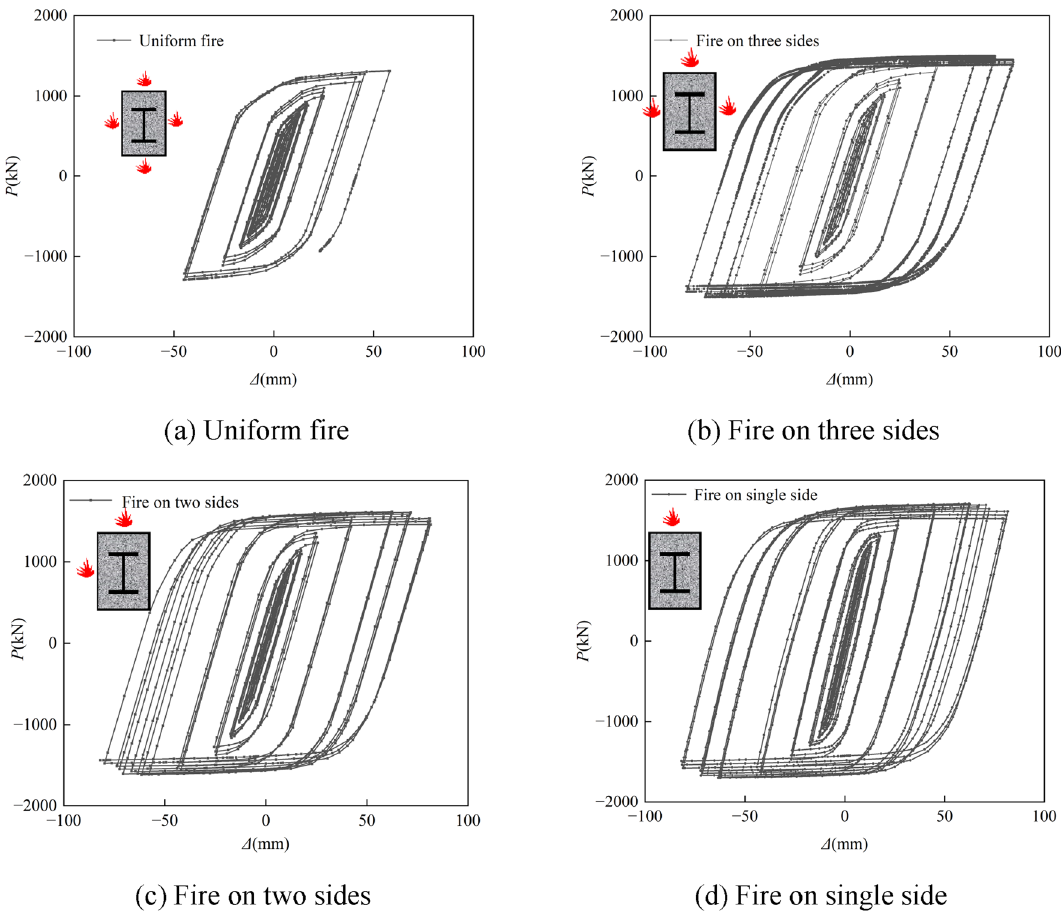
Figure 14. Hysteresis curves of P- Δ